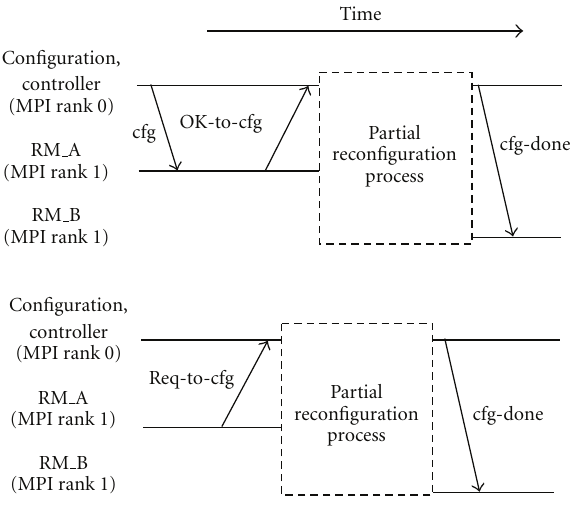
Figure 4: Explicit message synchronization between PR controller and